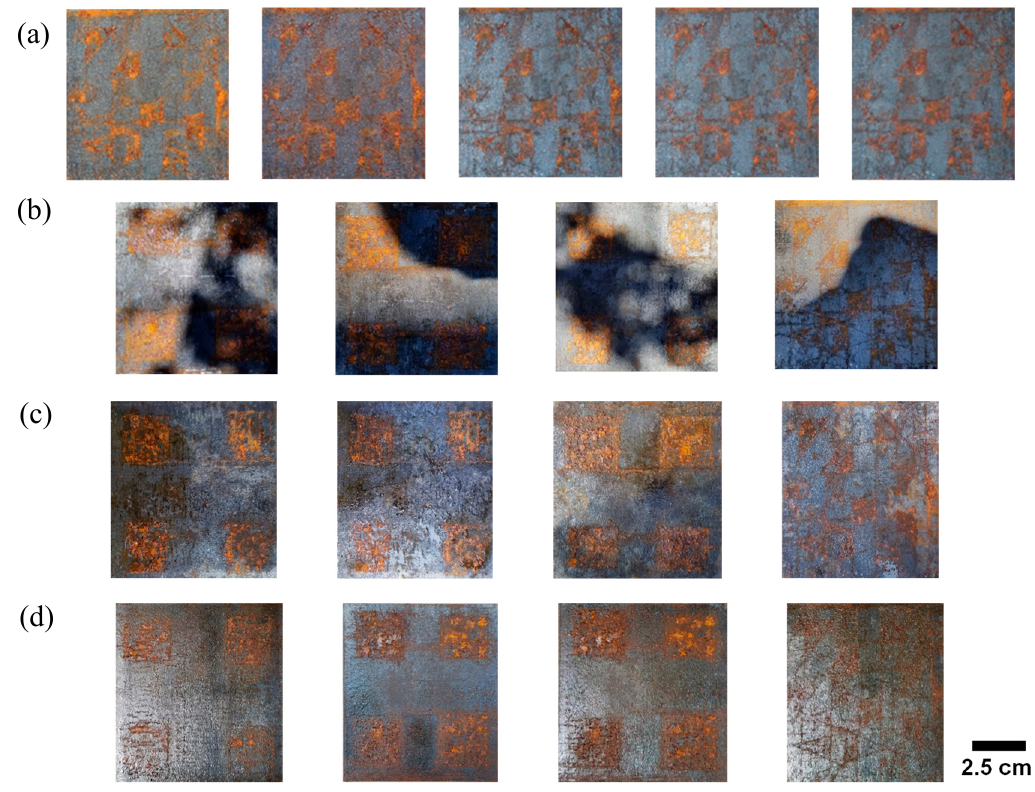
Figure 2. Images of partially corroded steel plates used for testing: ( a ) acquired at different illuminations of natural daylight, ( b ) shadows, ( c ) water wetting, and ( d ) oil wetting.